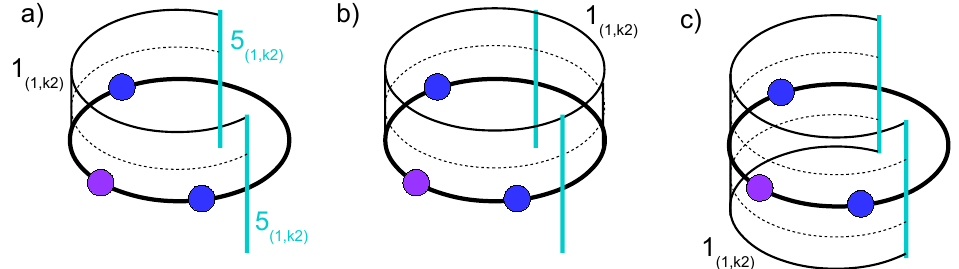
Figure 37 . (a) Brane setup with a semi-in(cid:12)nite 1 , inserting v + . (b) Brane setup leading (1 ;k 2 ) II; 1 to the relation v + v + = V + ( ’ 3 (cid:0) ’ 4 )( ’ 4 (cid:0) ’ 5 ). (c) Brane setup leading to the relation II; 1 II; 2 (1 ;k 2 ) v + v (cid:0) = ( ’ 4 (cid:0) ’ 3 )( ’ 4 (cid:0) ’ 5 ) X k 1 (cid:0) k 2 X k 2 X k 2 . The vertical direction is that spanned by the 5 1 2 5 II; 1 II; 1 in x 47